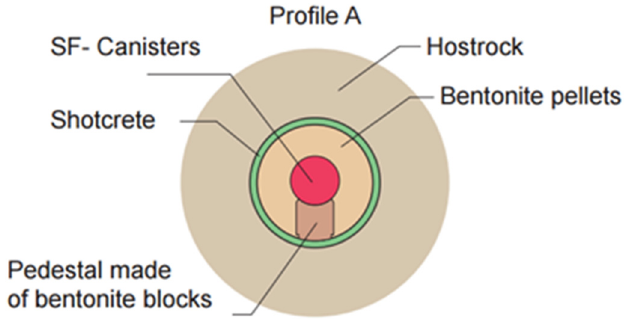
Fig. 2. Disposal cell in the Nagra concept.